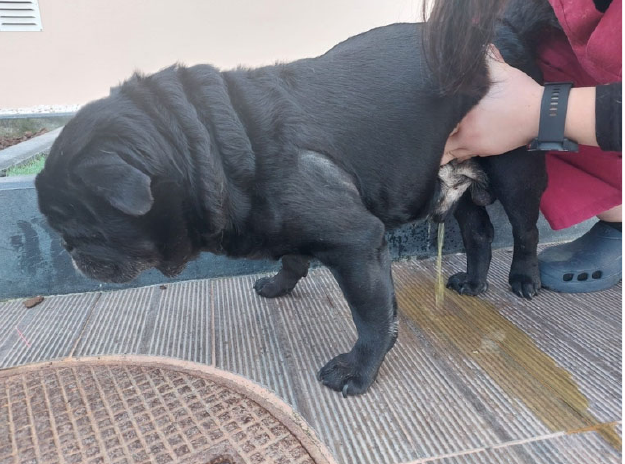
Figure 3. Manual bladder expression technique performed on a dog.